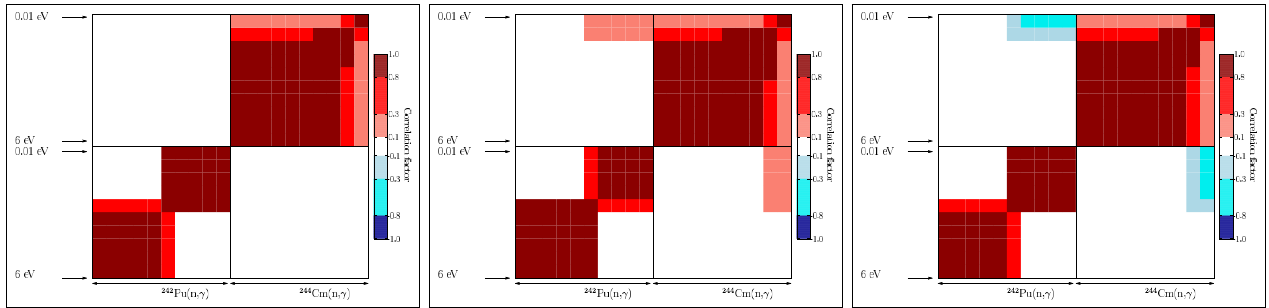
Fig. 1. Case of correlations between cross sections for 242 Pu(n, γ ) and 244 Cm(n, γ ). Left: prior correlation matrix without PIE data; middle: posterior correlation matrix built using the PIE measurement from 244 Cm; right: posterior correlation matrix built using the PIE measurement from 245